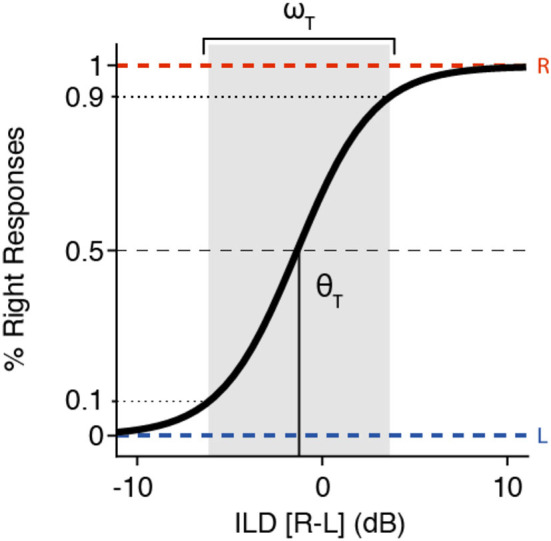
Example of an interaural level difference (ILD) psychometric curve, described by Equation (1), with its two parameters indicated. The shaded zone indicates the sensitivity range, ωT (here, ~10 dB) around the threshold, θT (here taken at −1.25 dB).